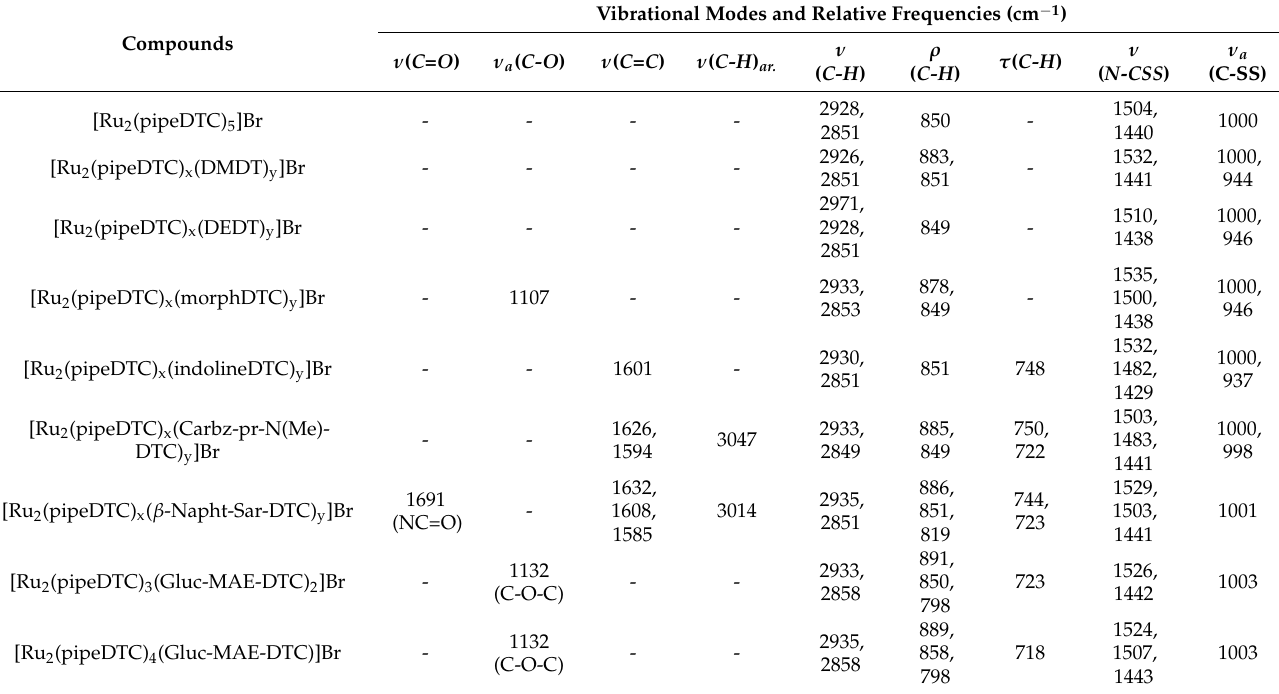
Table 2. Collection of the main IR-vibrations (4000–800 cm − 1 ) of the synthesized binuclear Ru(III)- DTC complexes.